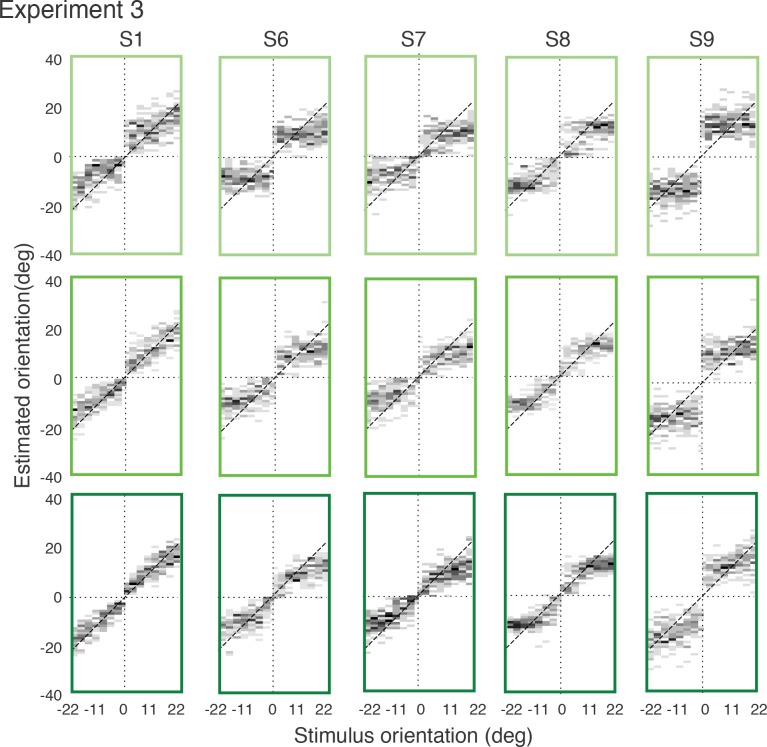
Full distributions of individual subjects’ estimates in Experiment 3.Each row corresponds to one of the three stimulus noise conditions (top-bottom: highest-lowest; color-code as in main text).